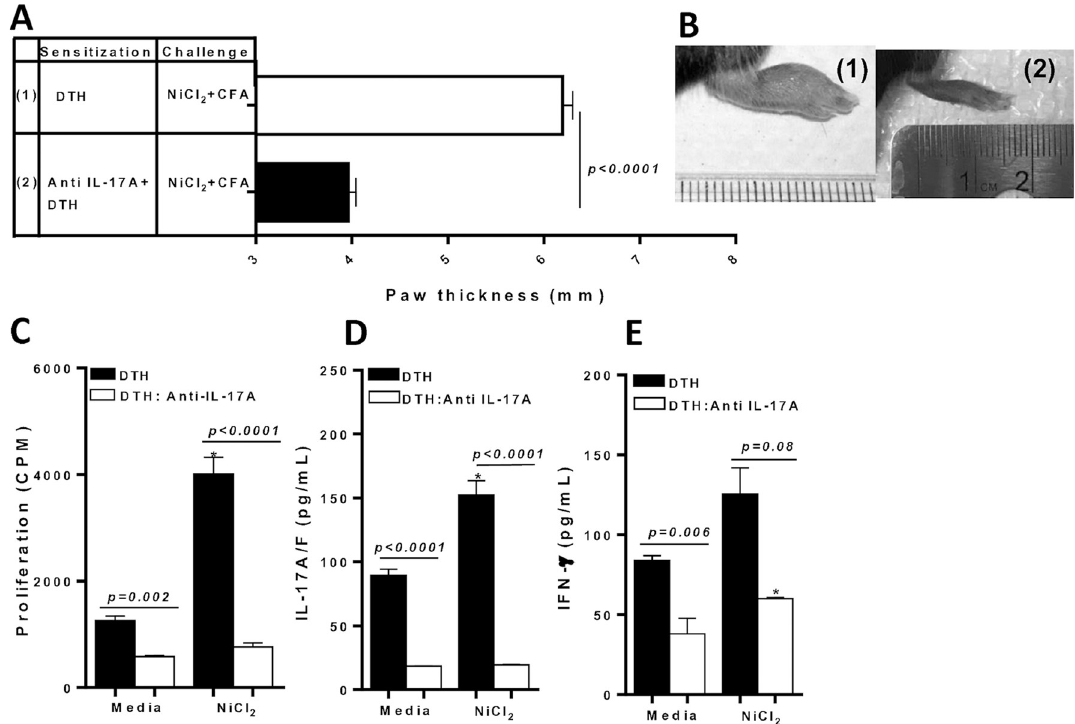
Fig 8. Inhibiting IL-17A bioactivity in vivo in metal-sensitized C57BL/6 mice effectively mitigates metal reactivity. (A) DTH was determined by measuring paw thickness 48 h after challenge in C57BL/6 mice that were sensitized and challenged as indicated on D 12. Sensitized mice in group 2 received systemic ip injection of Anti-IL-17A prior to metal sensitization and every 48 hrs until D 14. (B) Corresponding representative photographs of inflammatory lesions in the paw of metal-DTH treated mice on D 14. At D 14, spleens were harvested. (C) CD4+ T cells were purified from the spleens of either DTH C57BL/6 (black bars) or DTH Anti IL-17A treated C57BL/6 mice (white bars) and co-cultured with mitomycin-C treated na ï ve total spleen cells from C57BL/6 with Ni (0.001mM) challenge for four days. Proliferation of CD4+ T cells was measured by 3 H-thymidine incorporation. Supernatants were harvested and assayed by ELISA for (D) IL-17A/F and (E) IFN- γ . Data represent one of three independent experiments with 3–4 mice/ group in each experiment. Data are shown as mean ± SEM. Statistical significance was determined by Student’s unpaired two-tailed t- test ( � P � 0.05).